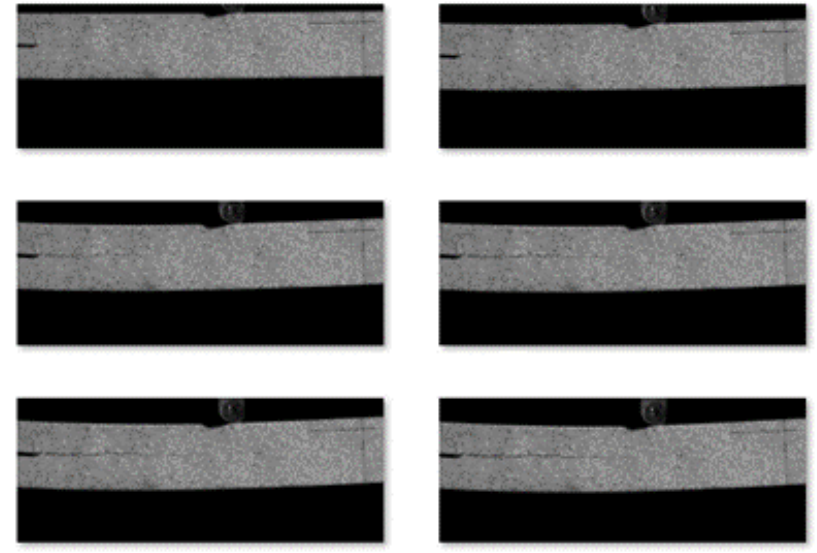
Figure 7. Examples of speckle images of engineered bamboo.